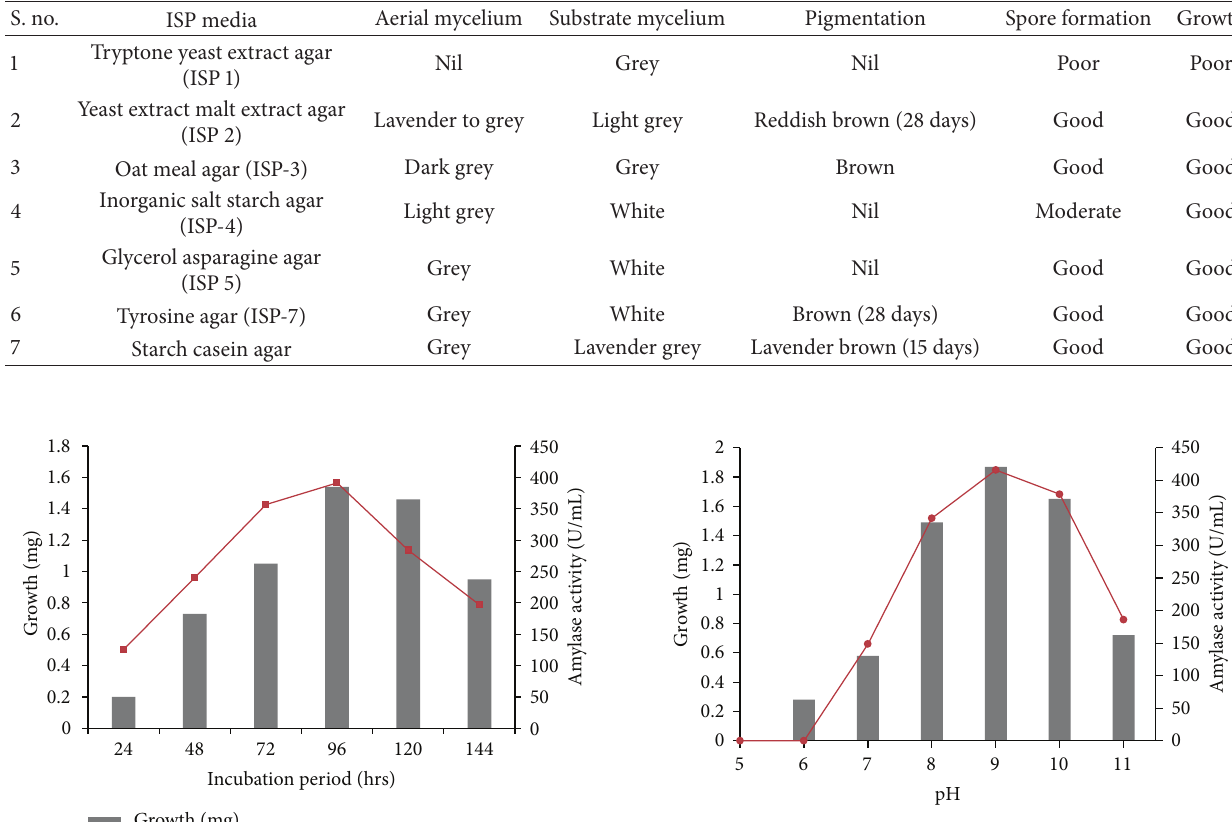
Table 2: Morphology of marine isolate BTSS 1001 on various ISP media.